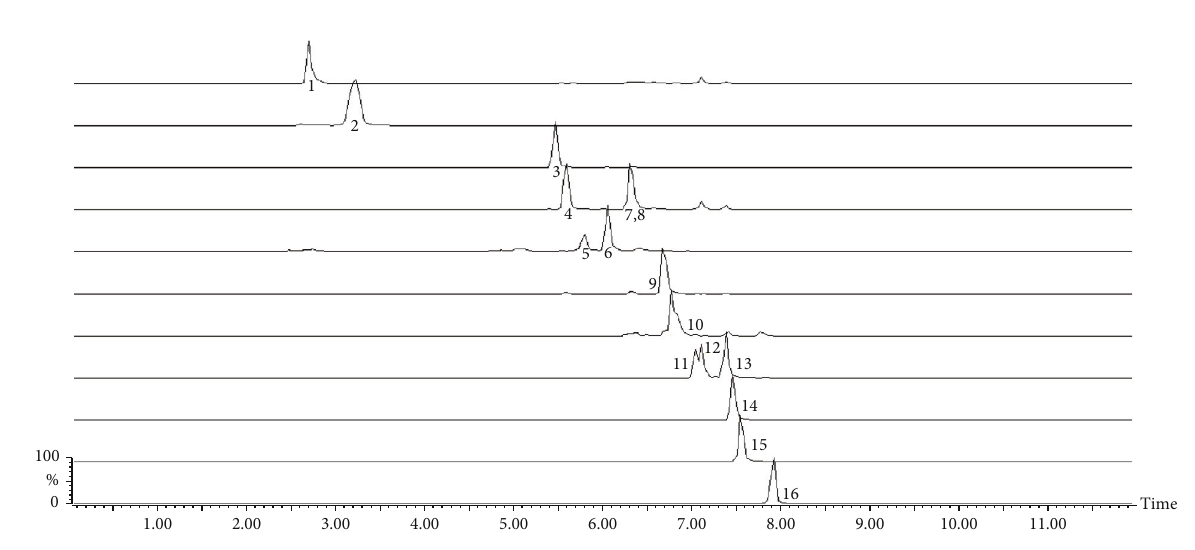
Figure 3: LC-MS chromatographic pro fi le of Ilex paraguariensis extract.